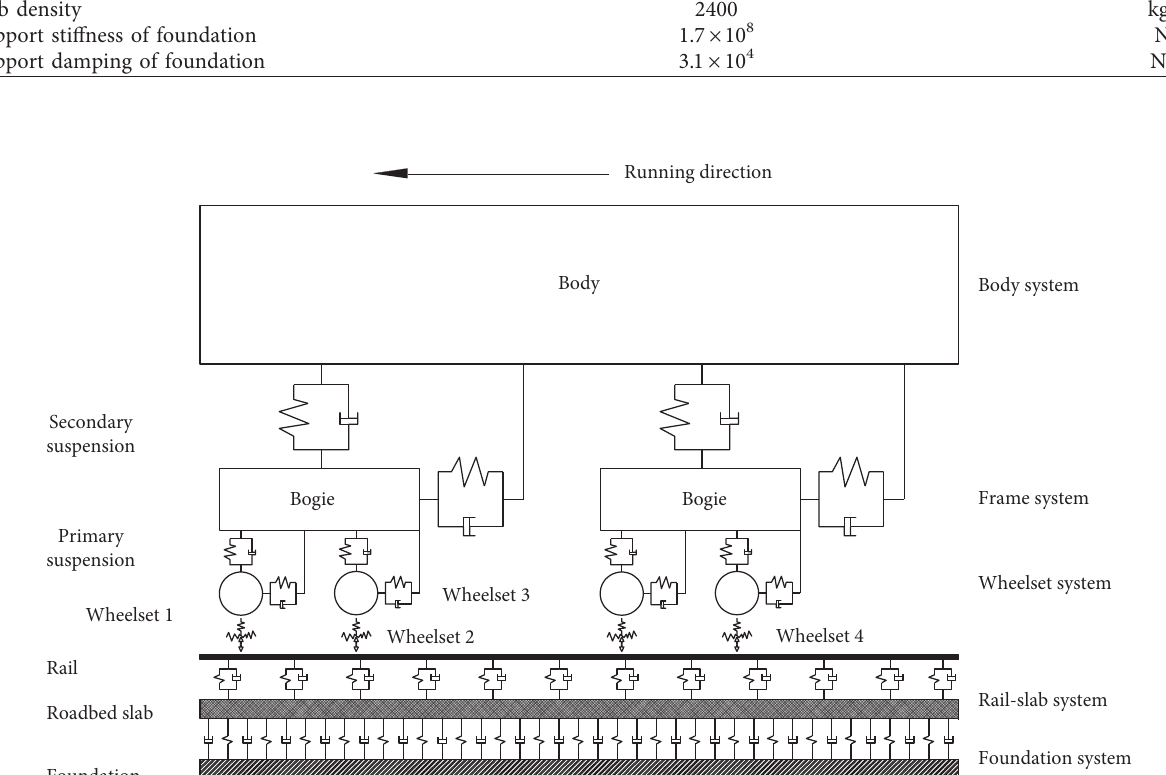
Figure 3: Schematic diagram of vehicle-track